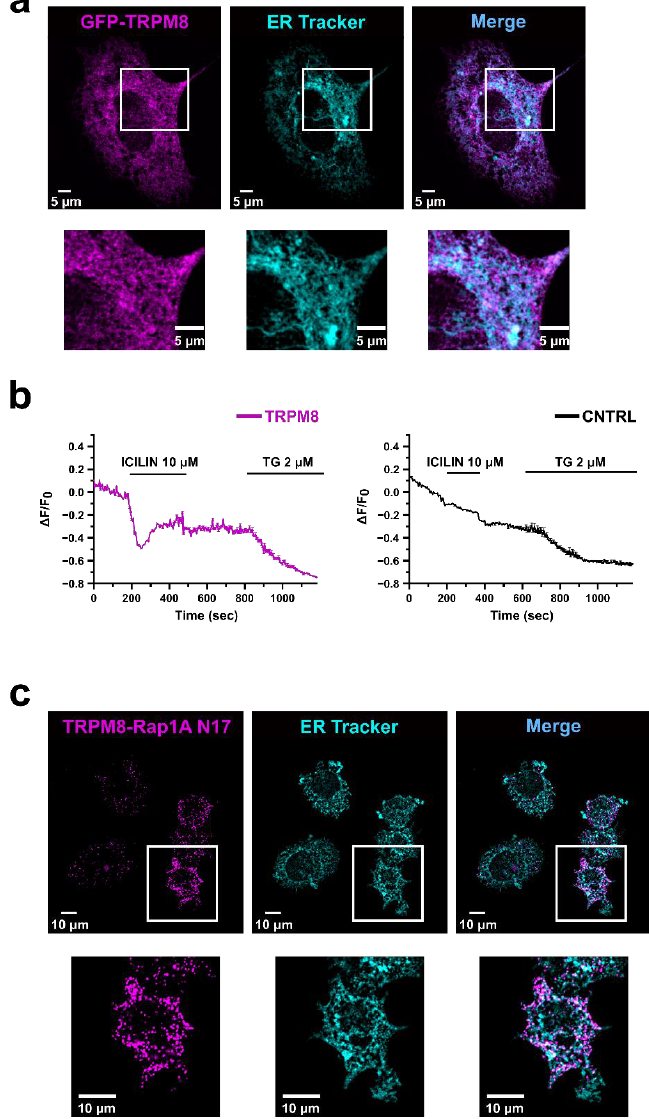
Figure 3. TRPM8 ER localization. ( a ) Representative confocal fluorescence images of PC3 cells 24 h after transfection with GFP-TRPM8. Magenta signal (on the left) refers to GFP-TRPM8 (excitation at 488 nm), cyan signal (in the center) refers to ER-tracker Red (excitation at 561 nm), and light blue in the merged image (on the right) indicates overlapped regions; below: zoom on a region of interest indicated by a white box. Scale bar: 5 µ m. ( b ) ER Ca 2+ -imaging traces in response to TRPM8 agonist (10 µ M icilin) and SERCA inhibitor (2 µ M thapsigargin) in PC3 transiently overexpressing GFP-TRPM8 (magenta) and PC3 used as control (black). [Ca 2+ ] ER was visualized in PC3 cells expressing GEM-Cepia1er, a Ca 2+ biosensor targeted to the ER. Traces represent the mean ∆ F/F 0 ± SEM from different ROIs within one representative cell for each condition ( n = 7 for PC3, n = 3 out of 15 for TRPM8). ( c ) Representative confocal fluorescence images of PC3 cells 24 h after transfection with TRPM8 wt and Rap1A N17. Magenta signal (on the left) refers to TRPM8-Rap1A N17 interaction detected as fluorescent PLA dots, cyan signal (in the center) refers to Ds-Red ER probe (excitation at 561 nm), and light blue in merged image (on the right) indicates overlapped regions; below: zoom on a region of interest indicated by a white box. Scale bar: 10 µ